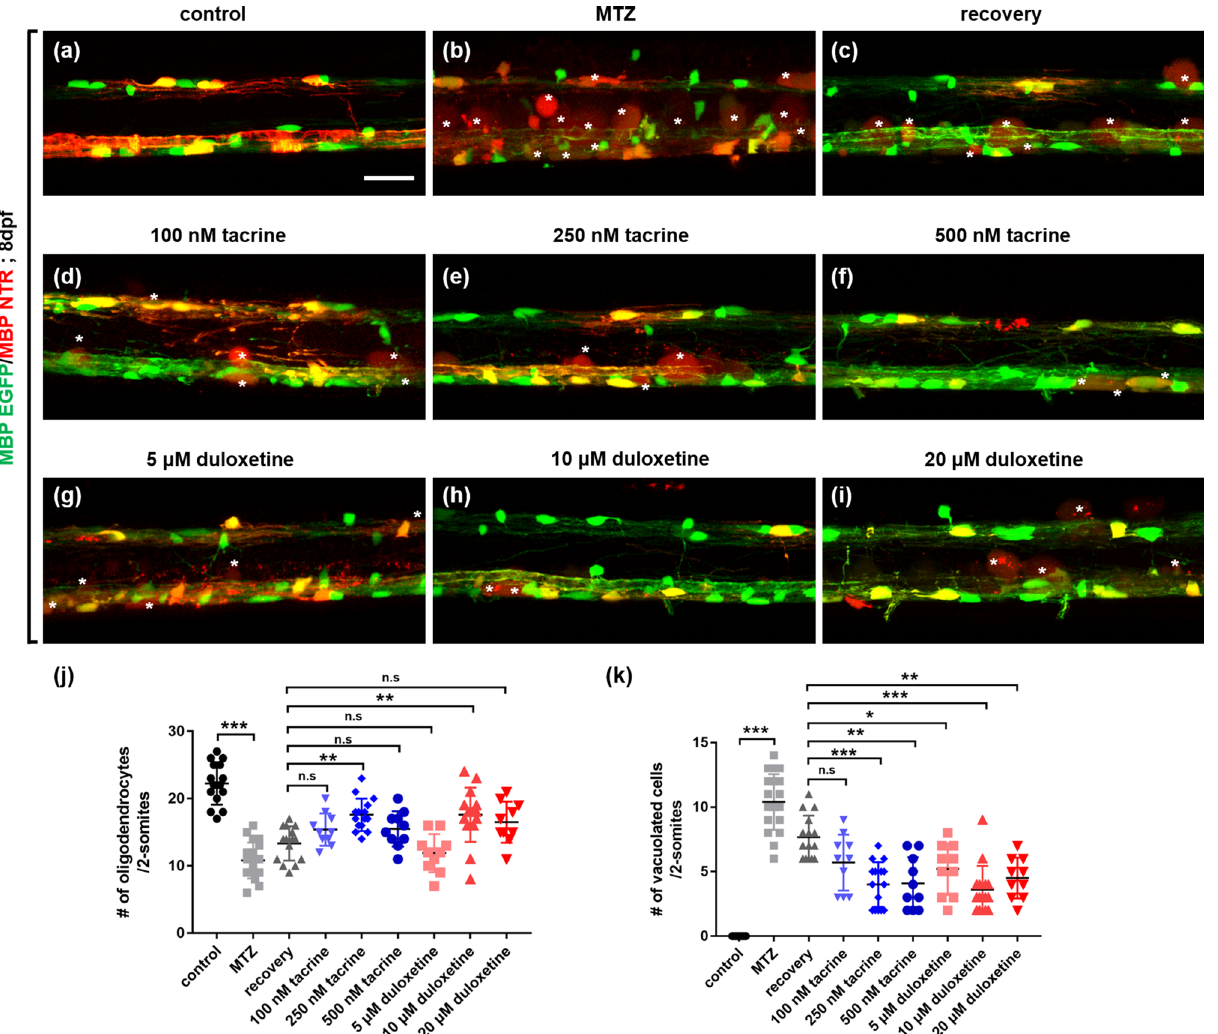
Figure 1. Effects of L1 mimetic compounds on the regeneration of oligodendrocytes in the spinal cord after oligodendrocyte ablation. All images are lateral views of the spinal cord of Tg(mbpa:gal4-vp16;uas:gfp;uas:NTR- mCherry) larvae at 8 days post-fertilization (dpf), anterior to the left and dorsal to the top. Fluorescence indicates MBP-positive oligodendrocytes and myelin sheaths in the spinal cord ( a–i ). White asterisks indicate debris of vacuolated oligodendrocytes. ( j ) Quantification of the number of oligodendrocytes per 2-somite area. Control: 22.27 ± 3.15, MTZ: 10.8 ± 2.90, recovery: 13.33 ± 2.55, 100 nM tacrine: 15.4 ± 2.41, 250 nM tacrine: 17.6 ± 2.41, 500 nM tacrine: 15.5 ± 1.64, 5 μM duloxetine: 11.9 ± 2.84, 10 μM duloxetine: 17.6 ± 4.05, 20 μM duloxetine: 16.5 ± 3.06. ( k ) Quantification of the number of vacuolated cells per 2-somite area. Control: 0, MTZ: 10.4 ± 2.36, recovery: 7.67 ± 1.68, 100 nM tacrine: 5.7 ± 2.16, 250 nM tacrine: 4 ± 1.73, 500 nM tacrine: 4.1 ± 2.02, 5 μM duloxetine: 5.2 ± 1.99, 10 μM duloxetine: 3.6 ± 1.84, 20 μM duloxetine: 4.5 ± 1.58. n = 15 for the control, recovery, 250-nM tacrine, and 10-μM duloxetine groups; n = 18 for the MTZ group; n = 10 for the 100- and 500- nM tacrine and 1-, and 20-μM duloxetine groups. *** p < 0.001; ** p < 0.01; * p < 0.05; n.s., not significant. Scale bar, 25